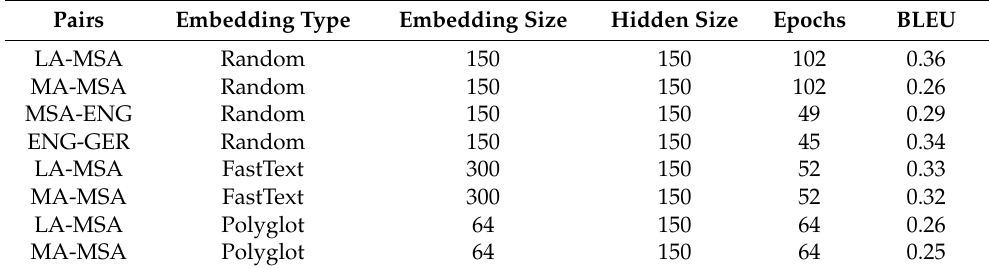
Table 1. Results of Multi-Task neural machine translation (NMT) without part-of-speech (POS) in terms of BLEU